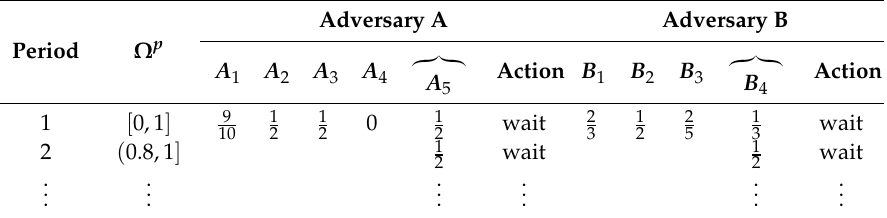
Table 3. Dynamics when true state of world is ω ∈ A 5 = ( 0.8,1 ]